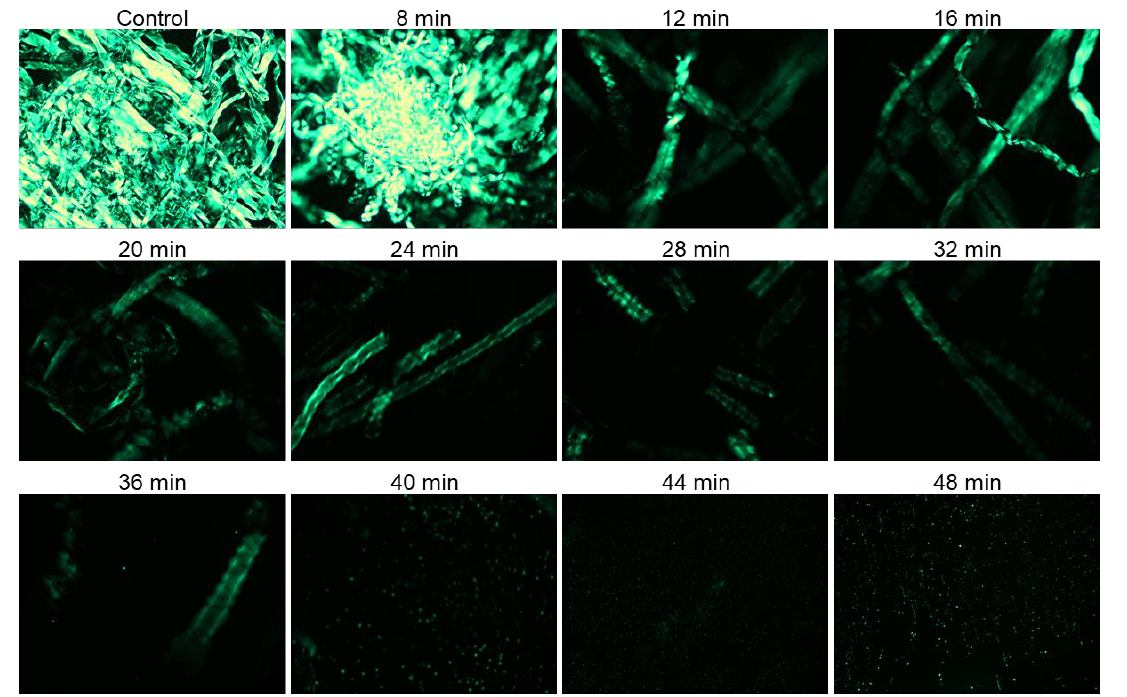
Figure 1. Polarized light microscopy images of 1% ( w / v ) cotton fibers/NaOH/urea solution after 30 min of dissolution in ambient temperature (magnification × 10): Cotton fibers were exposed to oxygen microwave plasma for different period of time.